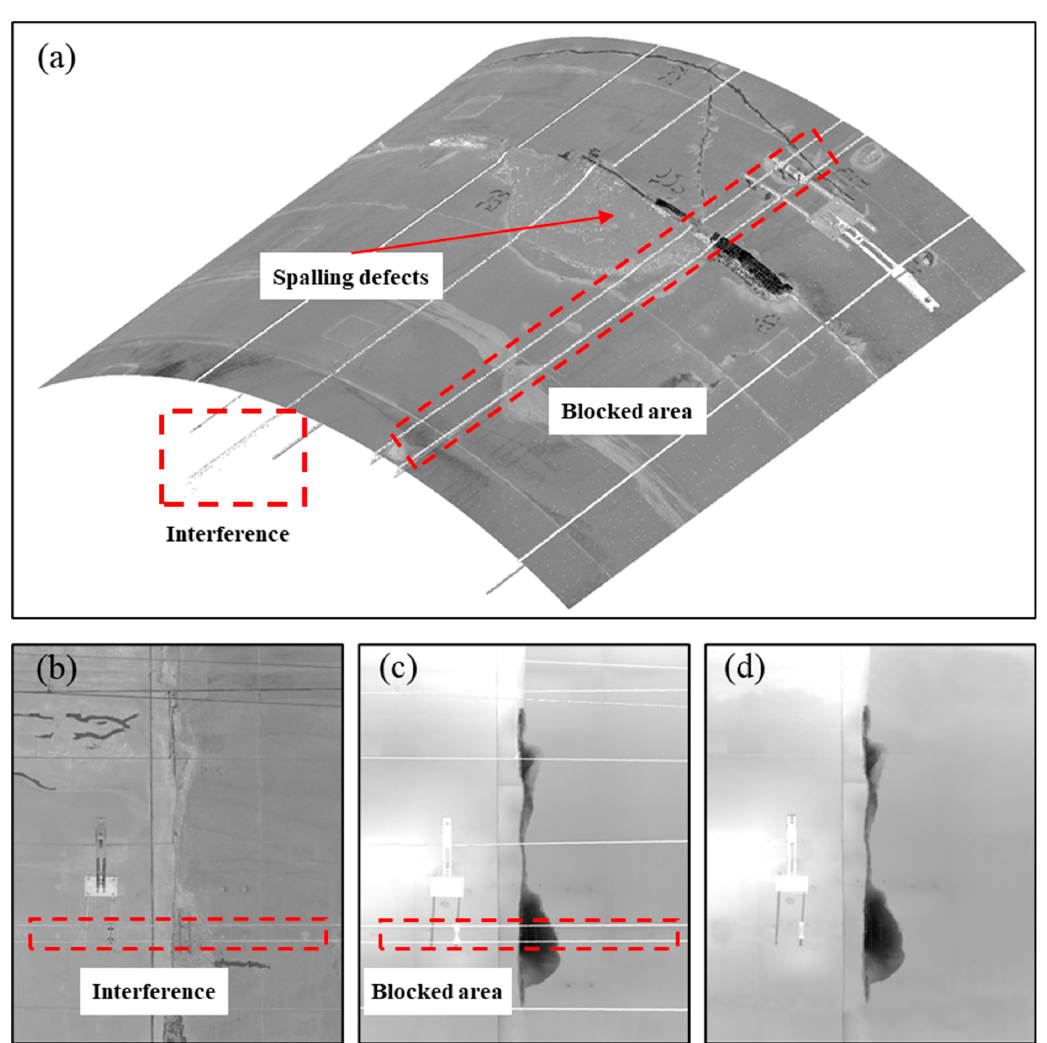
Figure 5. Removing the effect of interference: ( a ) tunnel point cloud data; ( b ) intensity image; ( c ) original depth image with interference parts, and ( d ) processed depth image without interference parts.